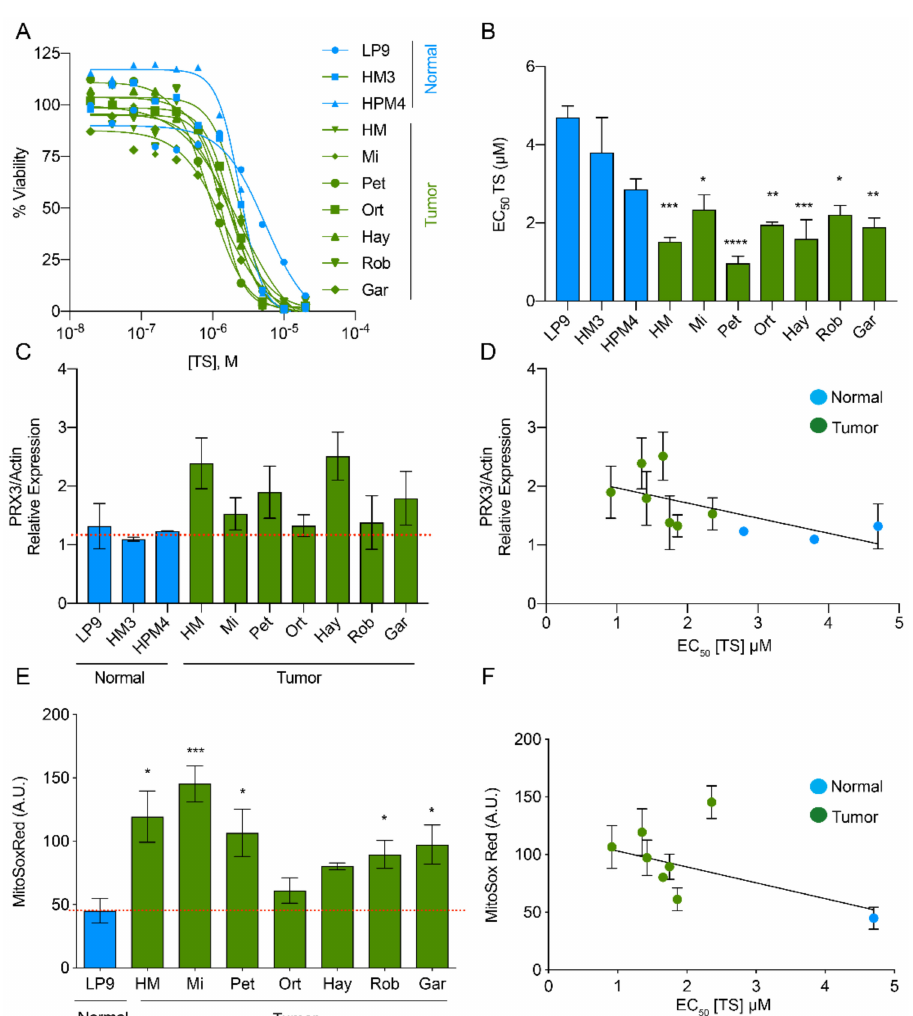
Figure 2. Mitochondrial ROS levels and PRX3 expression correlates with sensitivity to thiostrepton. ( A ) Dose-response curves of normal and MM tumor cell lines to thiostrepton (TS). ( B ) EC 50 values for TS in normal and MM cell lines (* p < 0.05, ** p < 0.01, *** p < 0.001, **** p < 0.0001, n = 4 biological replicates). ( C ) Relative PRX3 protein expression levels in MM tumor and normal cells (normalized to actin; See Figure S1 for representative Western blot). Red dotted line for reference to mean expression of PRX3 in normal cell lines (n = 2 replicates, ± SEM). ( D ) Relationship between PRX3 expression and EC 50 values for TS in normal and MM tumor cells ( p = 0.025, n = 2). ( E ) MitoSOX Red levels in normal and MM tumor cell lines (* p < 0.05, *** p < 0.001, n = 4). Red dotted line for reference to mean MitoSOX Red levels in normal cells (Of note, primary mesothelial cells were not amenable to analysis using MitoSOX Red). ( F ) Relationship between MitoSOX Red levels and EC 50 values for TS in normal and MM tumor cells (* p = 0.028, n =